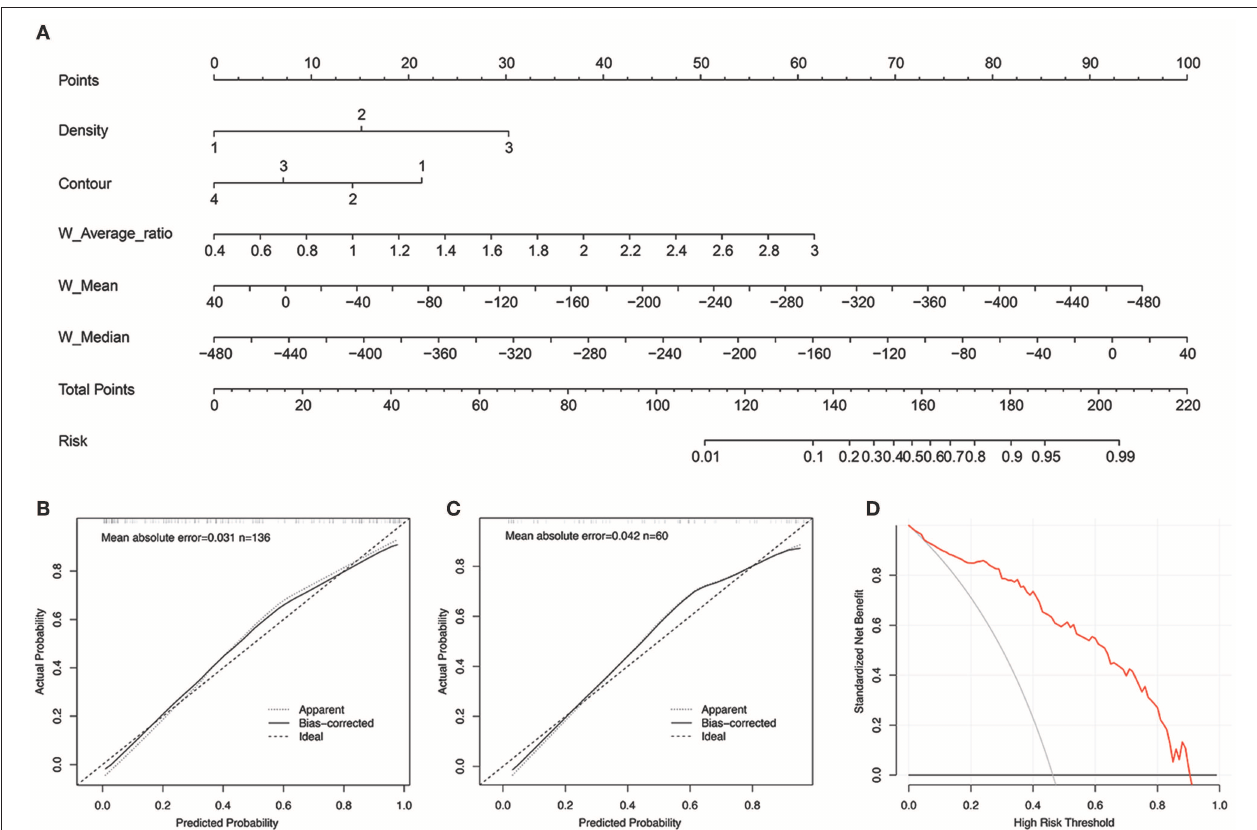
FIGURE 4 | (A) The developed morphological-histogram nomogram for predicting the probability of pulmonary metastases. By summing the scores of each point and locating on the total score scale, the estimated probability of pulmonary metastases could be determined. (B,C) The Calibration curves for predicting pulmonary metastases in the training and validation cohort. The y axis represents the actual rate of LM. The x axis represents the predicted probability of LM. The ideal line represents a perfect prediction by an ideal model. The apparent line represents the performance of the nomogram model, of which a closer fit to the ideal line represents a better prediction. (D) The decision curves analysis for the morphological-histogram nomogram. The red line represents the net benefit of morphological-histogram model. Across the various threshold probabilities, the morphological-histogram curve showed great net